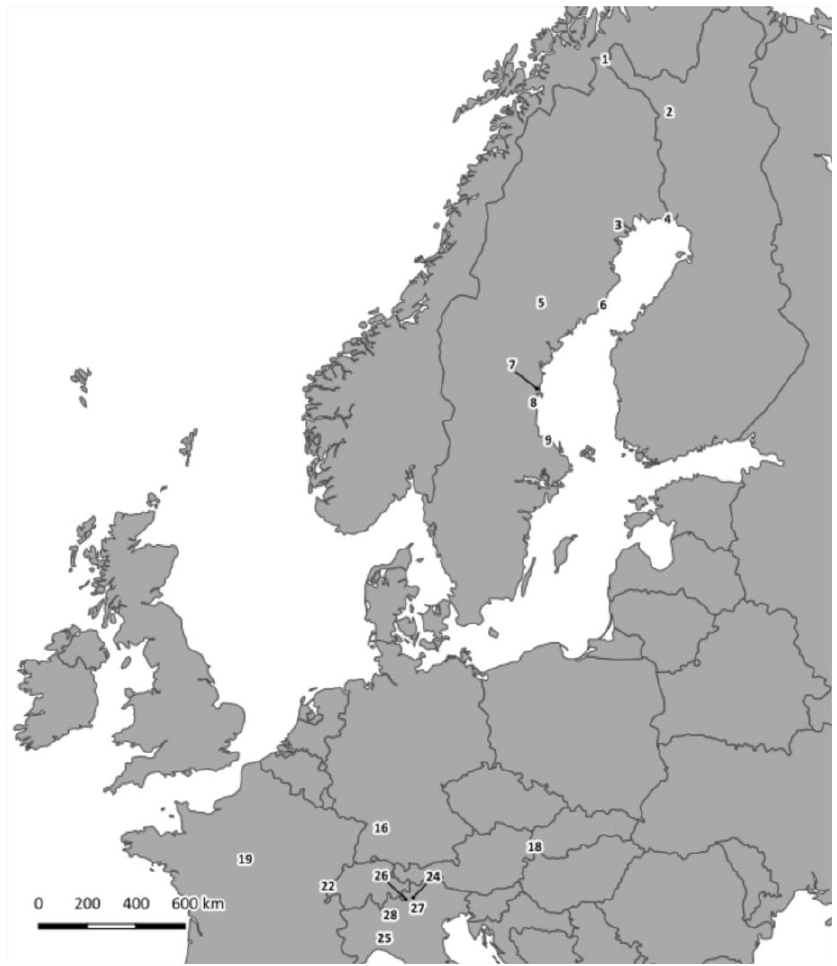
Figure 1. Map of sampling sites in Europe where LV sequences analyzed in this paper were detected. Numbers match those in Table S1. Number: nearest location, country (acronym) are: 1: Kilpisjärvi, Finland (KJ); 2: Pallasjärvi, Finland (PJ); 3: Harads, Sweden (HA); 4: Haparanda, Sweden (HP); 5: Fredrika, Sweden (FE); 6: Umeå coast, Sweden (UM); 7: Gnarp, Sweden (GN); 8: Enånger, Sweden (EN); 9: Tierp, Sweden (TI); 16: Weissach, Germany (WE); 18: Fugelka, Slovakia (FU); 19: La Venotiere, France (LA); 22: Mignovillard, France (MI); 24: Brescia, Italy (BS); 25: Pavia, Italy (PV); 26: Sondrio, Italy (SO); 27: Trento, Italy (TN); 28: Lecco, Italy (LC). Sites with numbers 10 – 15, 17, 20, 21, 23 and 29 are not shown here, as no LV RNA was detected in animals from these sites.